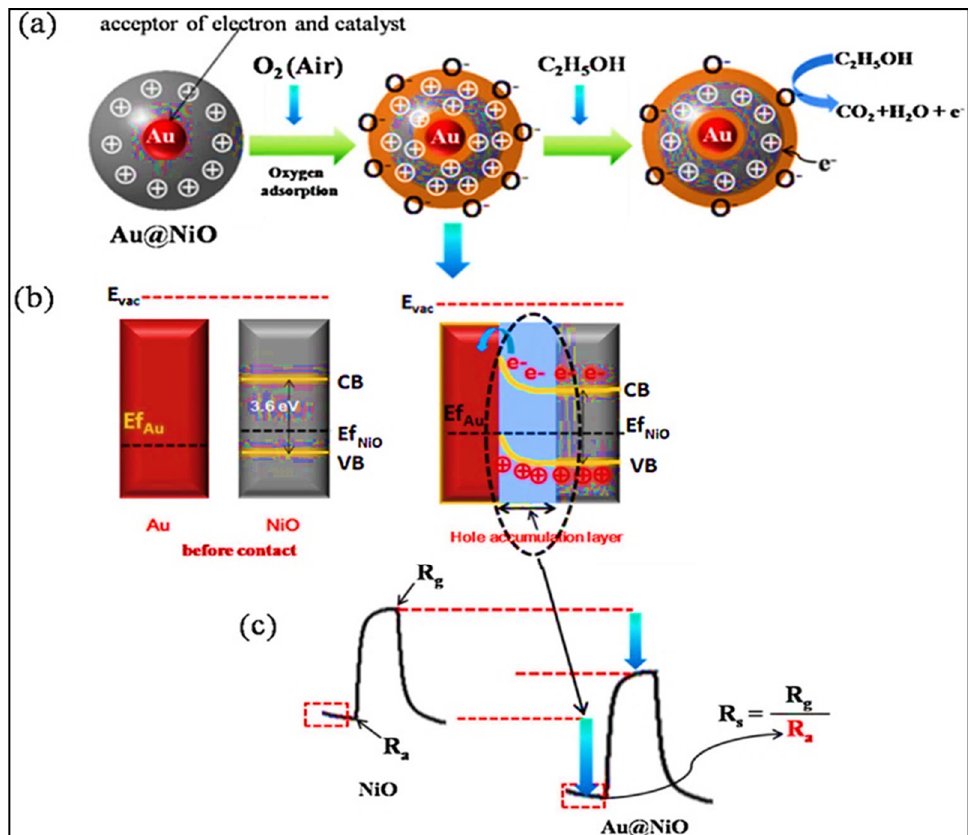
Figure 14. ( a ) C2H5OH-sensing mechanism of Au-NiO C-S NPs. ( b ) Formation of heterojunctions between Au and Ni ( c ) comparison of sensor signal in NiO and Au-NiO C-S NP gas sensors. Reproduced from [91] with the permission of Elsevier.